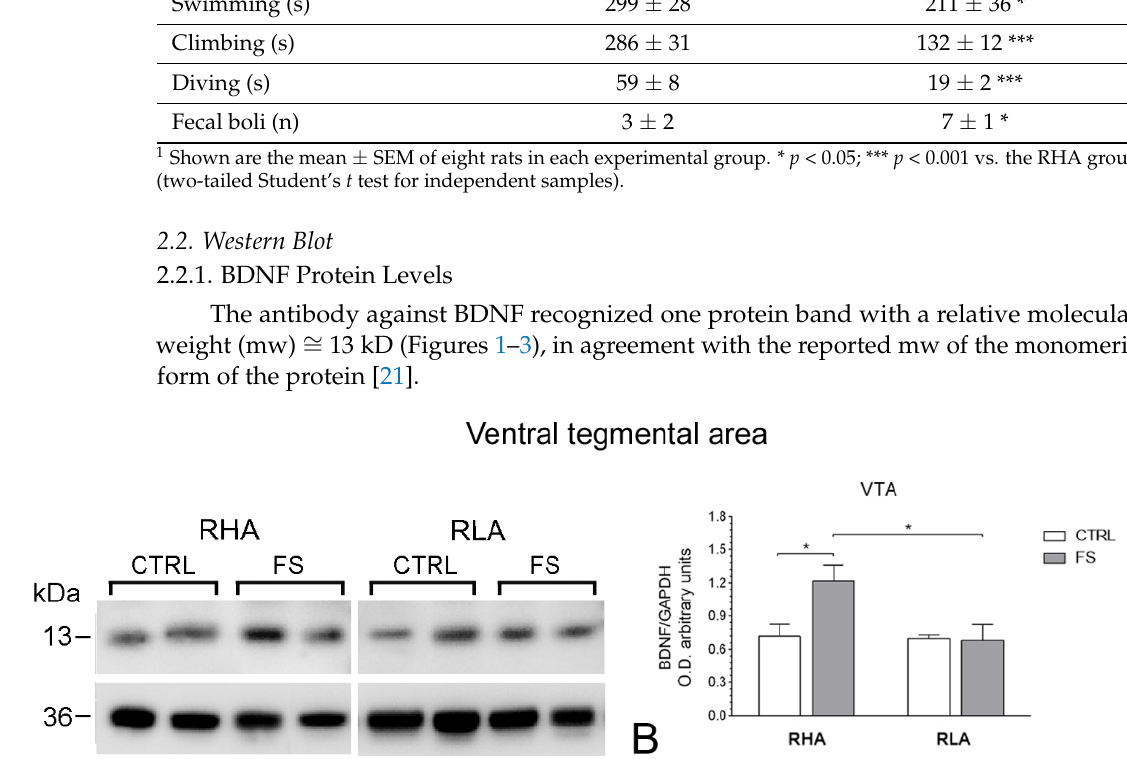
Figure 2. Western blot analysis of brain-derived neurotrophic factor (BDNF) protein levels in the nucleus accumbens shell ( A , B ) and core subregions ( C , D ) of RHA and RLA rats under baseline conditions (CTRL) and after a 15 min session of forced swimming (FS). ( A , C ) shown are repre- sentative samples from two rats; and ( B , D ) densitometric analysis of the BDNF/GAPDH band gray optical density (O.D.) ratios. Columns and bars denote the mean ± S.E.M. of eight rats in each ex- perimental group. *: p < 0.05 (Tukey’s post hoc test or Sidak’s correction for multiple comparisons).